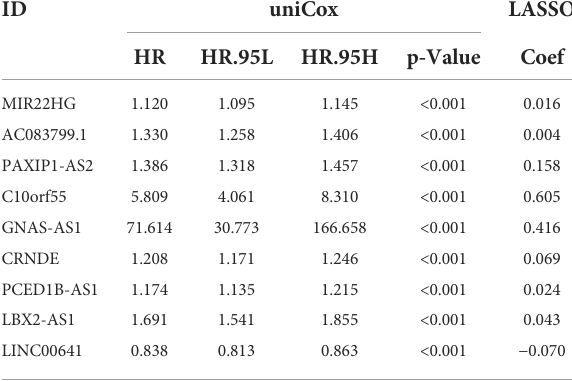
TABLE 1 Nine necroptosis-related lncRNAs in the prognostic classi fi er associated with overall survival in